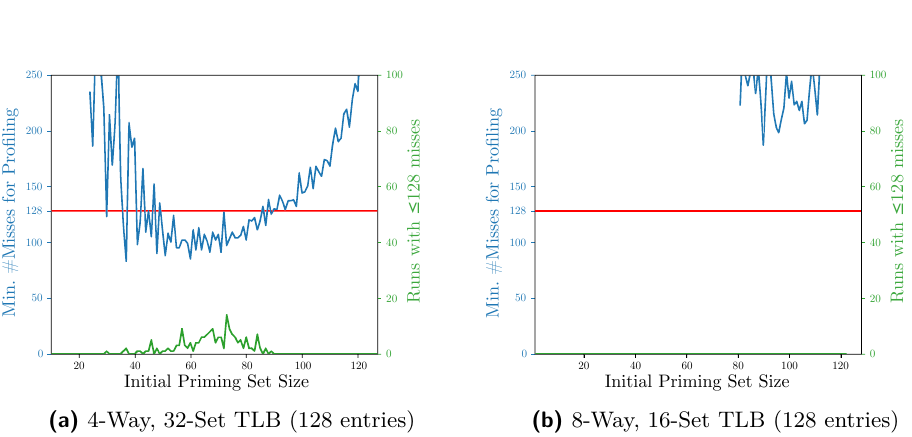
Figure 10: The blue line depicts the minimum experienced misses to obtain a functional probabilistic eviction set during profiling of Prime+Prune+Probe over 100 , 000 trials for each initial priming set size. Assuming a re-randomization threshold of N (the number of entries available), the green line depicts the total number of successful runs out of the 100 , 000